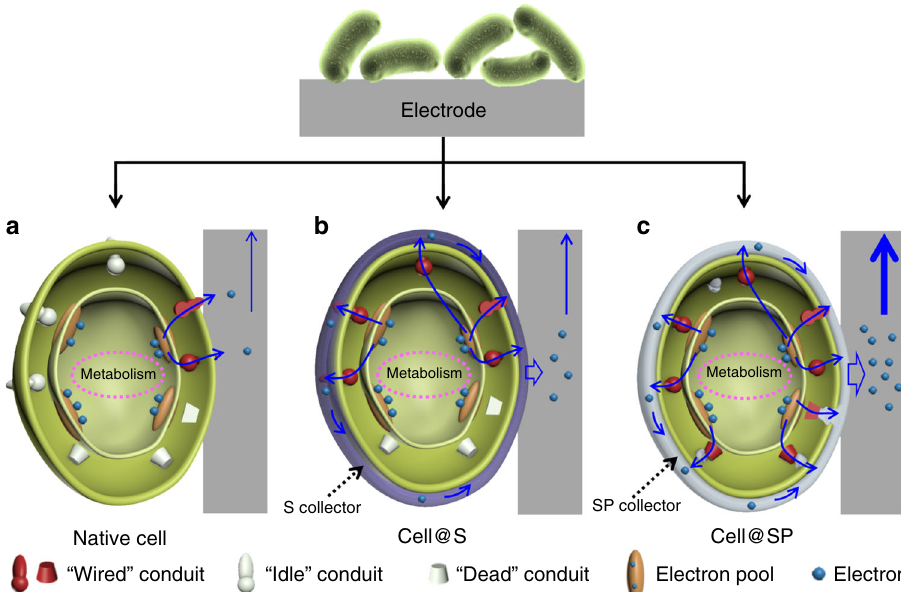
Fig. 1 Schematic of biointerfacial electron transfer between an electrode and cells. a Native cell, b S collector encapsulated cell (cell@S) and c SP collector encapsulated cell